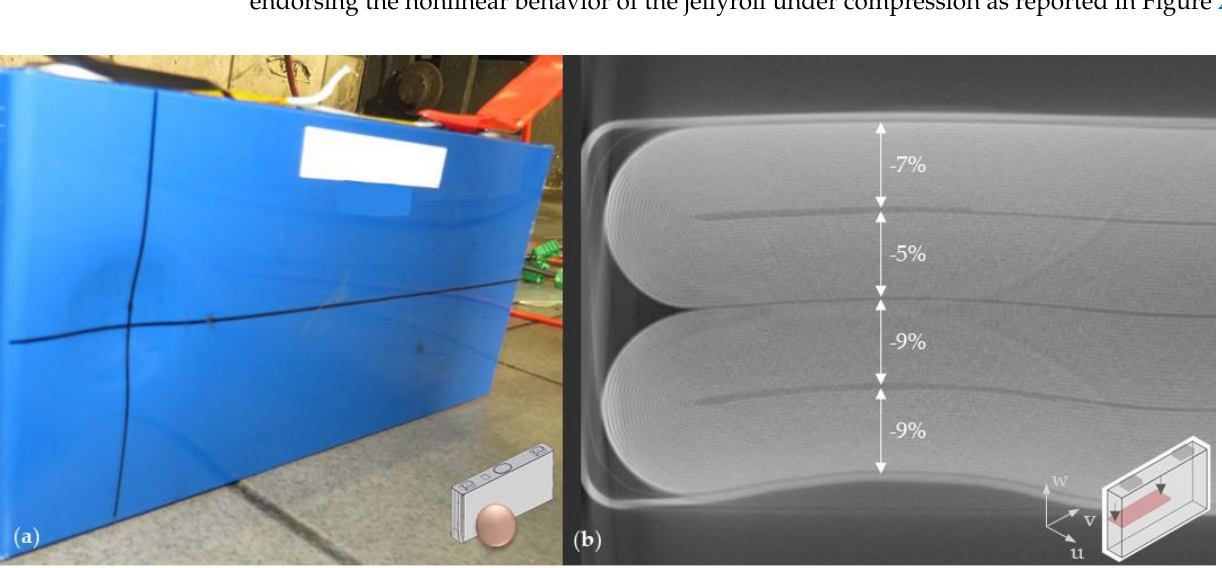
Figure 10. Compression force and state of charge over time for middle and right cells at test in w- direction with hemispherical impactor.